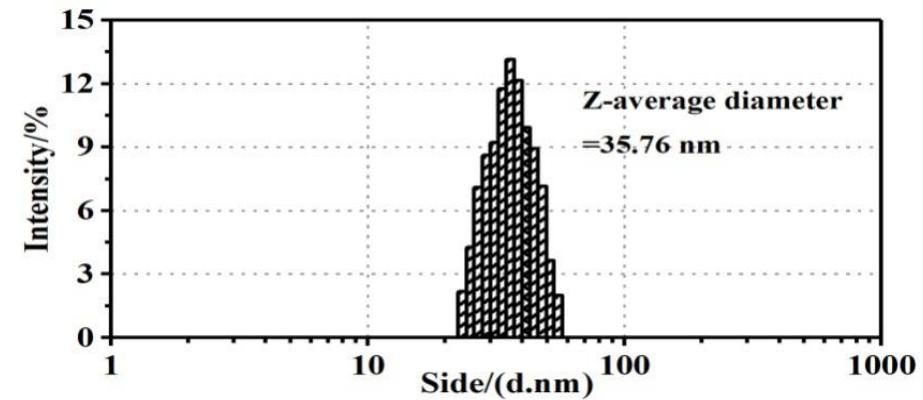
Figure 3. Particle size distribution of Ag NPs.